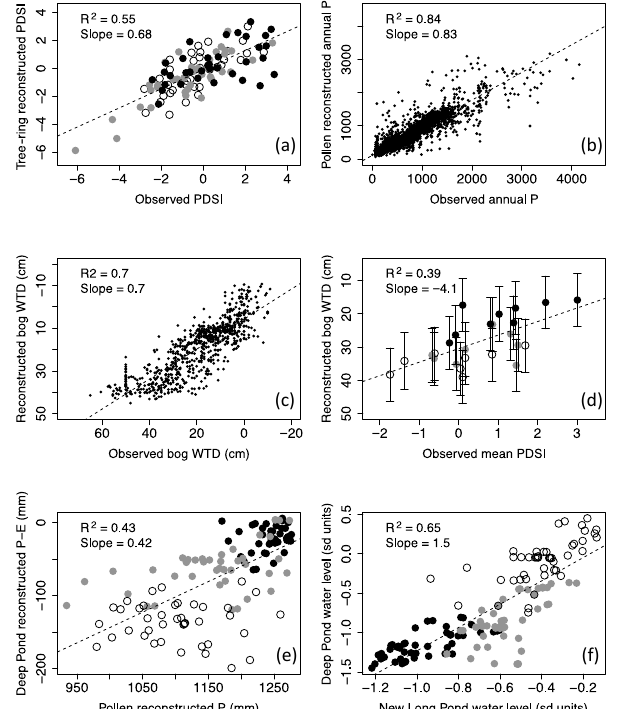
Figure 4. Calibration, internal validation, and multi-proxy compar- ison data for tree rings, pollen, lake levels, and bogs. (a) Instrumen- tal (observed) versus reconstructed New York PDSI for 1895–2000 from tree rings; (b) observed versus reconstructed annual precipi- tation from pollen data (Marsicek et al., 2013); (c) observed versus reconstructed water table depth (WTD) from testate amoebae across North America (Booth, 2008); (d) Hole Bog, Minnesota WTD ver- sus instrumental PDSI for 1895–2003 (which uses the mean PDSI for each of the sample intervals; Booth, 2008); (e) Deep Pond lake- level-derived P - E reconstruction versus the mean annual precipi- tation reconstruction based on the mean of multiple records in the region (Newby et al., 2014); (f) New Long Pond versus Deep Pond water elevations from southeastern MA for the past 7000 years (Newby et al., 2014). Comparisons in panels (e) and (f) include re- construction error and temporal error because the two datasets in each case come from different sets of cores. For all plots, black- filled dots are the oldest one-third, gray are the middle third, and unfilled are the youngest third. Note that panels (b) and (d) have declining